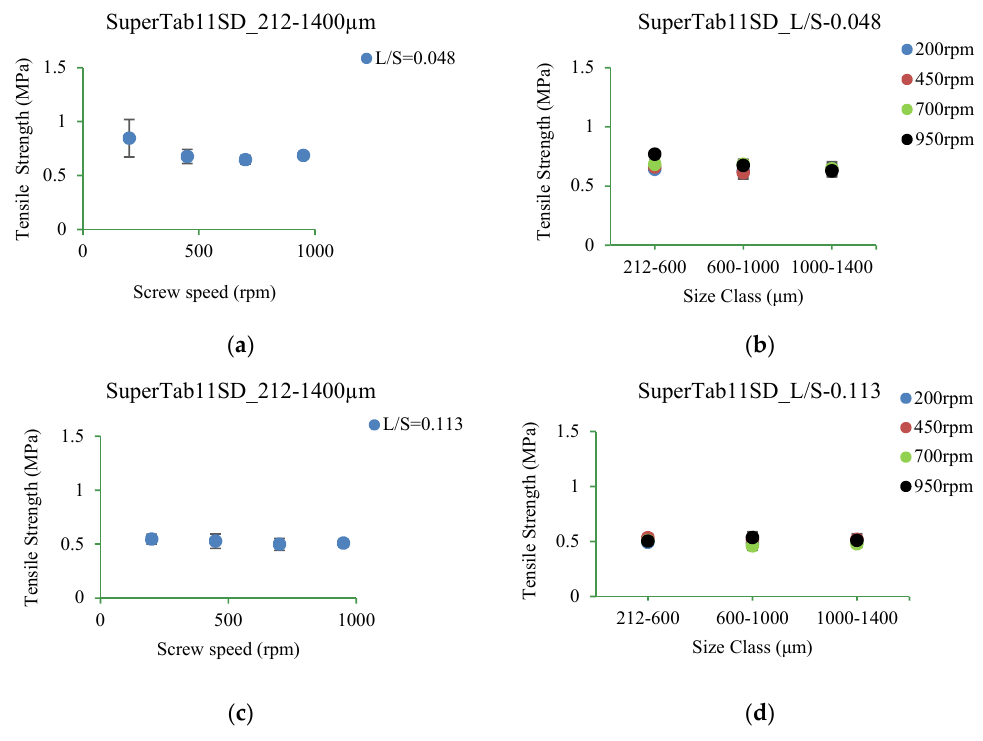
Figure 16. Tensile strength of tablet of granules at different size classes of SuperTab11SD. ( a ) 212–1400 μ m at L/S of 0.048; ( b ) 212–600 μ m, 600–1000 μ m, and 1000–1400 μ m at L/S of 0.048; ( c ) 212–1400 μ m